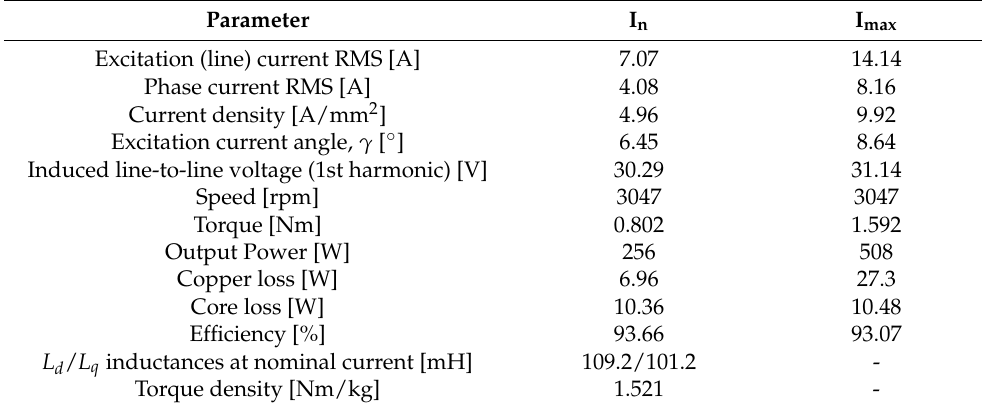
Table 3. Motor parameters at nominal speed, at nominal (I n ) and maximum current (I max ).